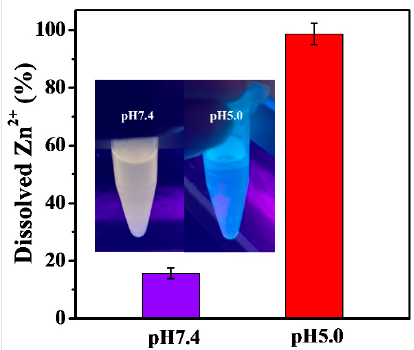
Figure 3. The percentage of dissolved Zn 2+ in pH 7.4 and pH 5.0 phosphate-buffered saline (PBS) and the digital photographs (the inset images) of ZnO QDs dispersed in pH 7.4 and pH 5.0 PBS